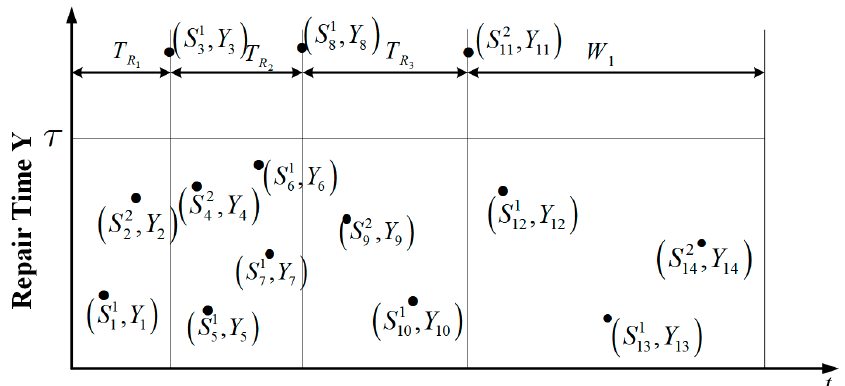
{ , ,1} N t model. Figure 2. A possible product state evolution path under { τ , N } 1 ,1 1